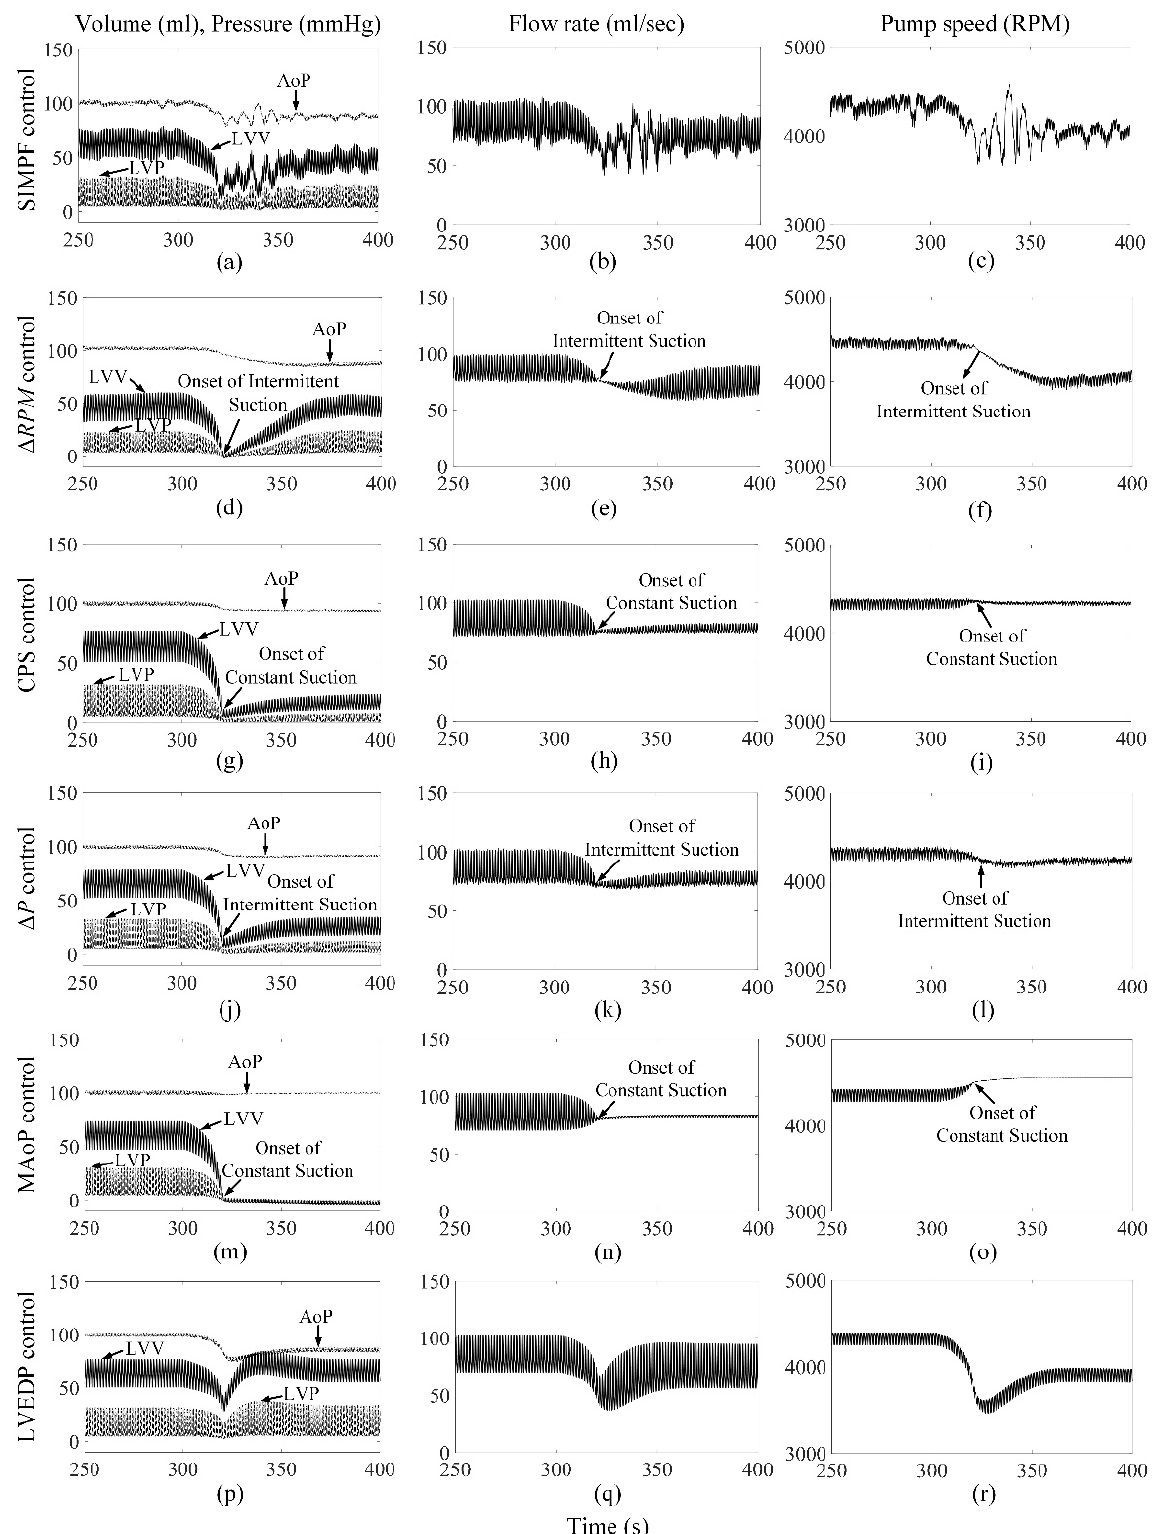
Figure 5. Comparison of performance among six control strategies at rest when the PVR increased eight times for DP2. The increase in PVR started when t = 300 s. ( a − c ) SIMPF control with 5% noise. ( d − f ) ∆ RPM control. ( g − i ) CPS control. ( j − l ) ∆ P control. ( m − o ) MAoP control. ( p − r ) LVEDP control. SIMPF and LVEDP control did not cause any LV suction. ∆ RPM and ∆ P control induced intermittent suction. CPS and MAoP control induced constant suction.